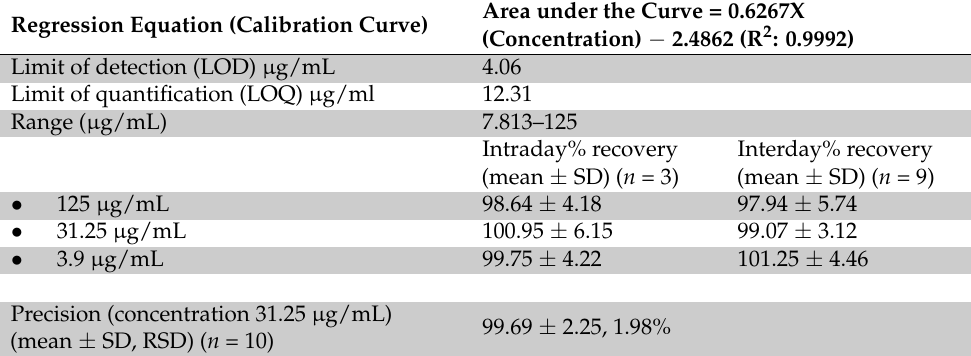
Table 5. Validation parameters of PMZ using the HPLC